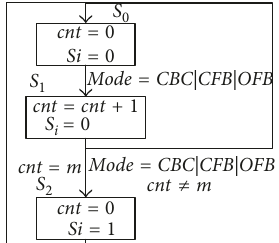
Figure 7: Dual-channel selection control of preprocessing module.